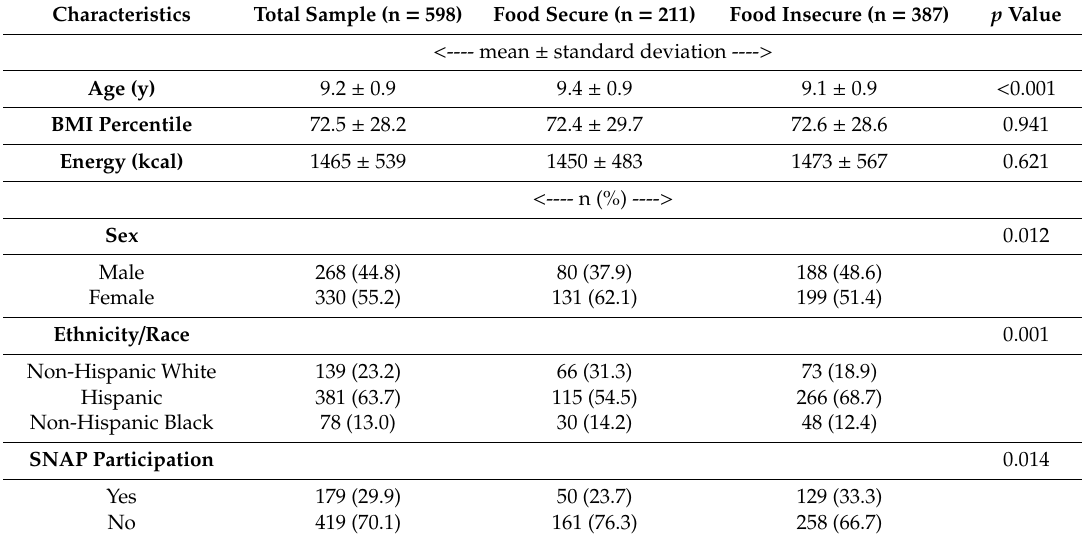
Table 1. Characteristics of Children by Child-Reported Food-Security Status a